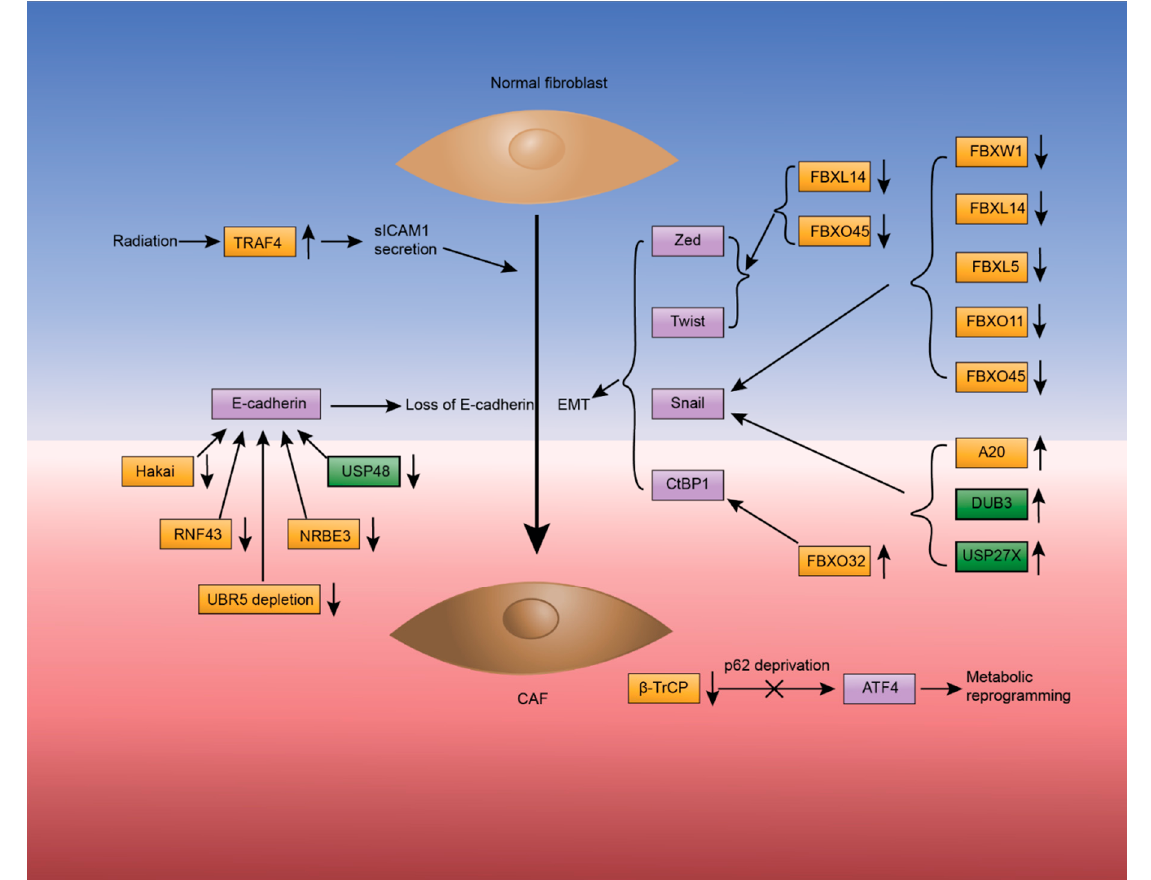
Figure 3. Ubiquitin signaling regulates transformation of normal fibroblasts into cancer-associated fibroblasts (CAF). CAF features in metabolic reprogramming, sICAM1 secretion, epithelial-mesenchymal-transition (EMT) and loss of E-cadherin. For metabolic reprogramming, β -TrCP can down-regulate ATF in a p62 dependent manner as p62 deprivation prevents ubiquitination of ATF and facilitates metabolic reprogramming. TRAF4 E3 up-regulates the secretion of Sicam1. Additionally, the transcription factors Zed, Twist and Snail and their cofactor CtBP1 are involved in EMT. FBXL14 and FBXO45 down-regulate both Zed and Twist. FBXW1, FBXL14, FBXL5, FBXO11 and FBXO45 down-regulate Snail, whereas A20, DUB3 and USP27X stabilize and up-regulate it. FBXO32 up-regulates the cofactor CtBP1. Finally, depletion of a DUB USP48 and several E3 ligases, such as Hakai, RNF43, NRBE3 and UBR5, are implicated in the loss of E-cadherin.